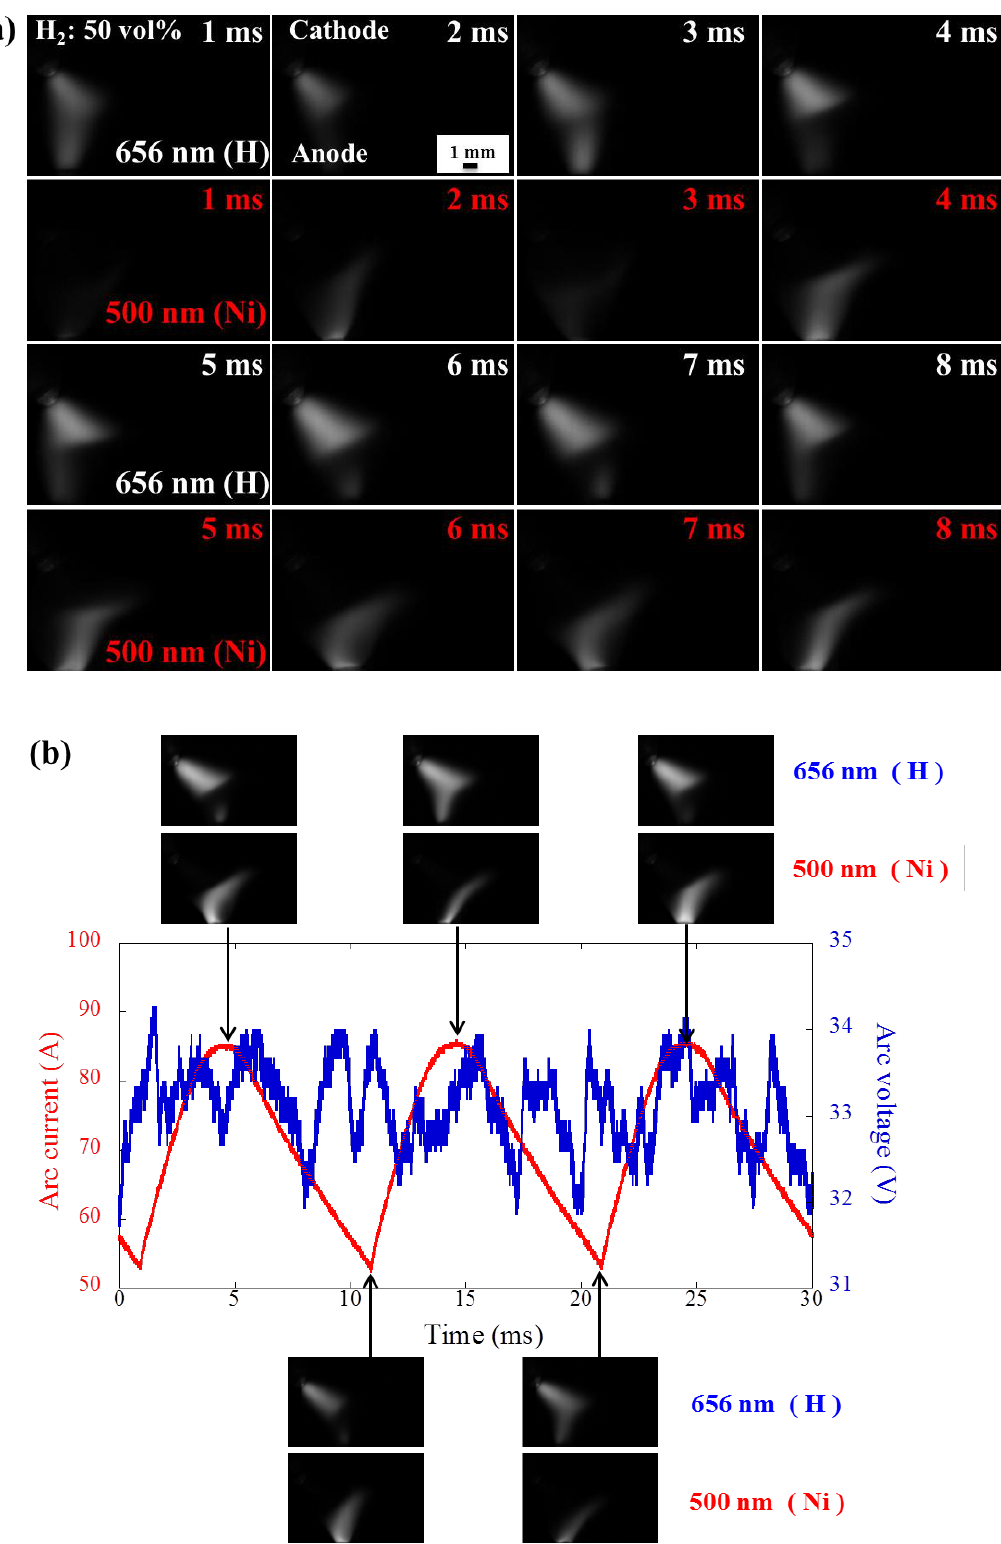
Figure 4. ( a ) Representative snapshots of the high-speed camera in argon arc when hydrogen concentration is 50 vol%. H and Ni emissions are the upper and lower ones, respectively; ( b ) Corresponding voltage and current waveform of argon arc synchronized with the snapshots of H and Ni emissions.